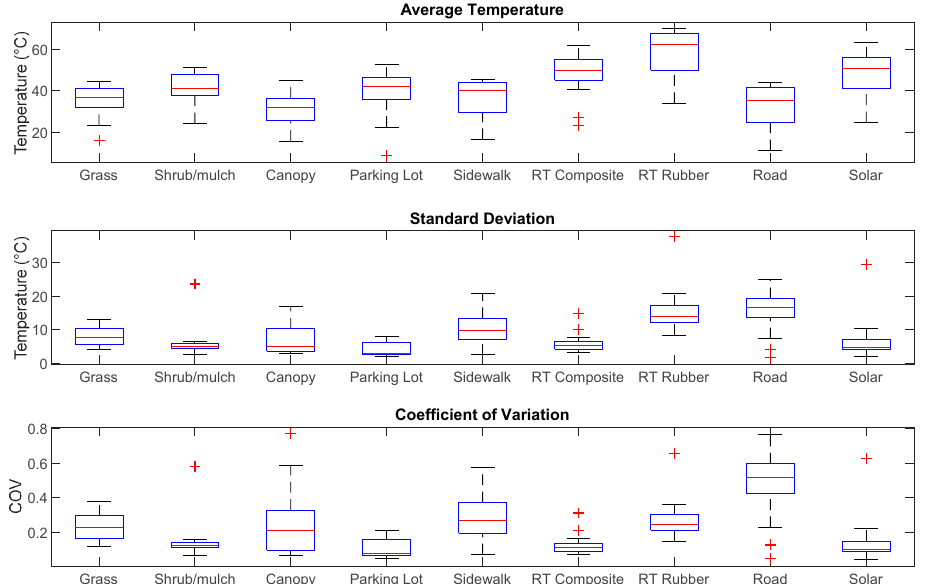
Figure 4. Boxplot distribution of average temperature, standard deviation and coe ffi cient of variation from 14 recorded flights in Milwaukee, Figure 4 . Boxplot distribution of average temperature, standard deviation and coefficient of variation from 14 recorded flights in Milwaukee, WI.